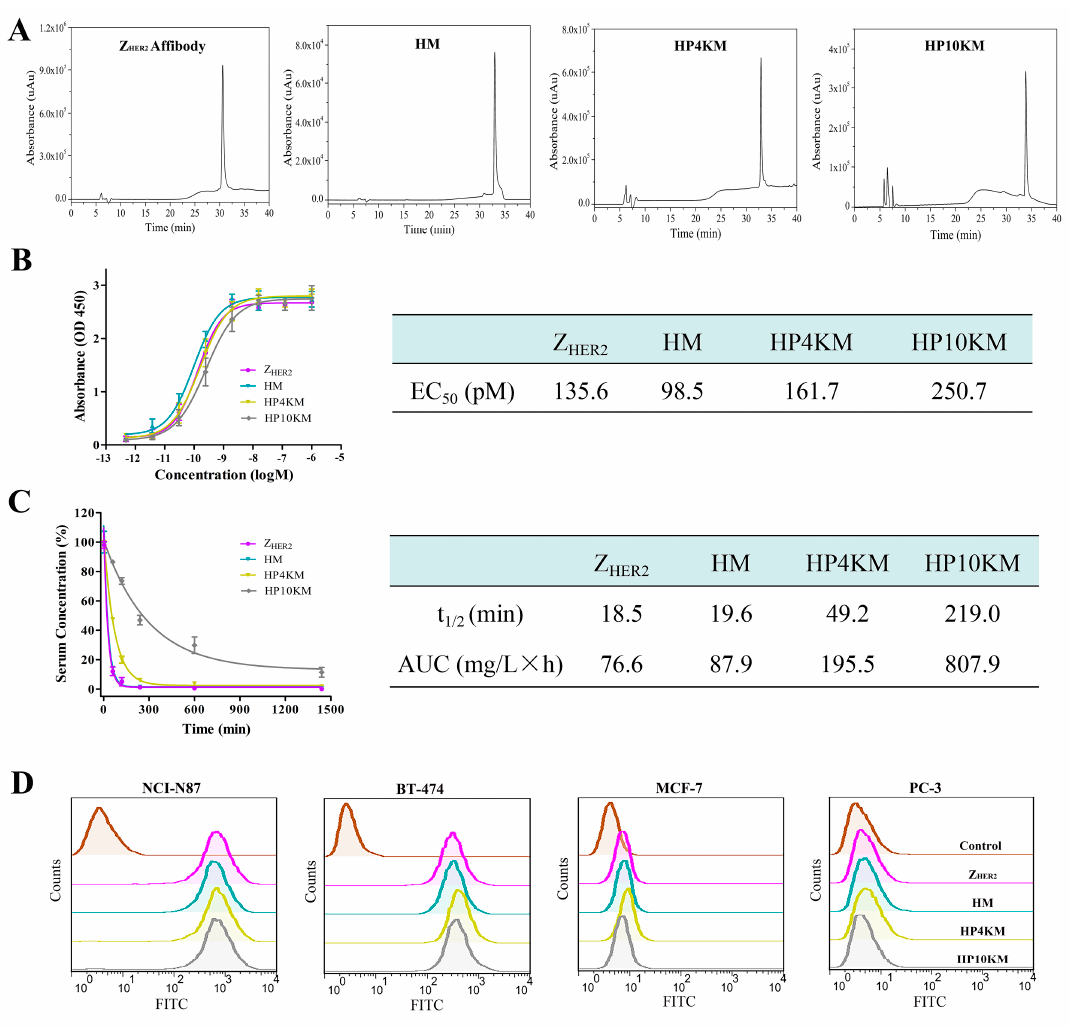
Figure 2. HPLC characterization and determination of the affinity and half-life of the HM, HP4KM, and HP10KM conjugates. ( A ) HPLC analysis of affibody Z HER2:2891 and the conjugates on a C-4 column. ( B ) Binding analysis of the conjugates towards HER2 receptors by ELISA. ( C ) Circulation clearance of the conjugates determined by ELISA. Serum samples were collected from BALB/c mice injected with the conjugates at different time points post injection, and the concentration of the residual conjugates in the plasma was determined by ELISA. t1/2: half-life. AUC: area under the curve from zero to infinity. ( D ) Binding specificity of the conjugates detected by flow cytometry. Data were expressed as the mean ± SEM ( n = 4).